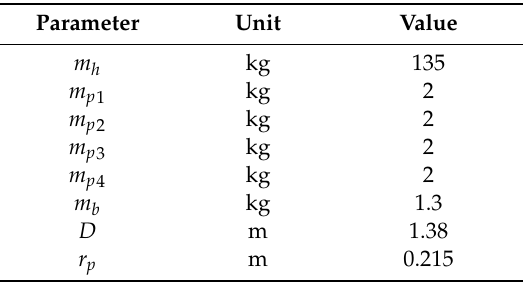
Table 4. Main parameters of the